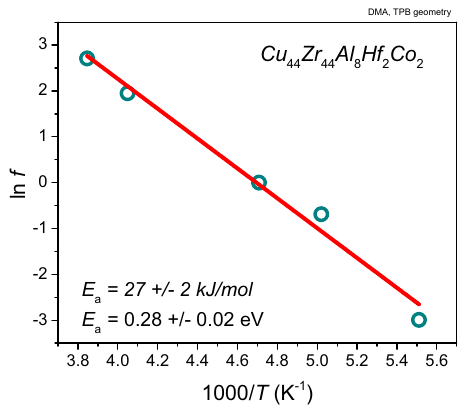
Fig. 7 Activation energy of the γ -relaxation. Arrhenius plot of the frequency ( f ) dependence of the γ -transition yielding activation energy on the order of 27 ± 2 kJ mol − 1 = 0.27 ± Table 1 Activation energies for the α - , β -, and γ -relaxation derived from the DMA experiments.